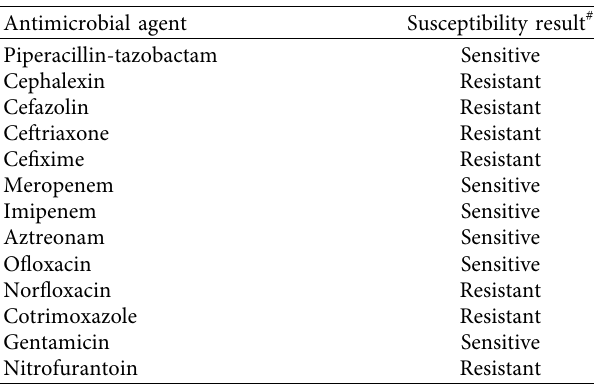
Figure 1: Chromobacterium violaceum in Cysteine Lactose Elec- trolyte Deficient agar. Table 1: Antimicrobial susceptibility test